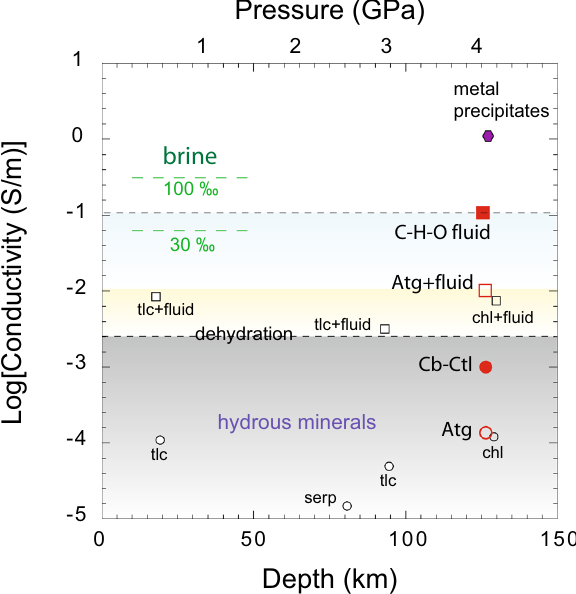
Figure 6. A compilation of electrical conductivity data of layered hydrous silicate minerals and released aqueous fluids upon dehydration and metal precipitates that are often facilitated by dehydration. The electrical conductivity data reported in this figure are from previously reported electrical conductivity studies on talc (tlc) 45,83 , serpentine (serp), and chlorite (chl) 24 . The electrical conductivity of hydrous minerals, aqueous fluids released via dehydration in subduction-zone settings, and metal precipitates are segregated by dashed horizontal lines. It also shows that the electrical conductivity of C–H–O aqueous fluids is quite high compared to the normal aqueous fluids. However, the formation of interconnected networks of metal precipitates is likely to generate the highest electrical conductivities in subduction zone settings 24